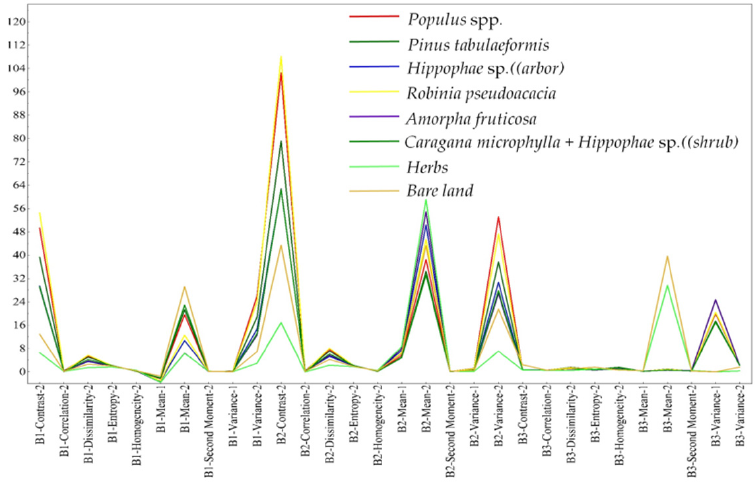
Figure 9. Textures of eight types of vegetation species composition.